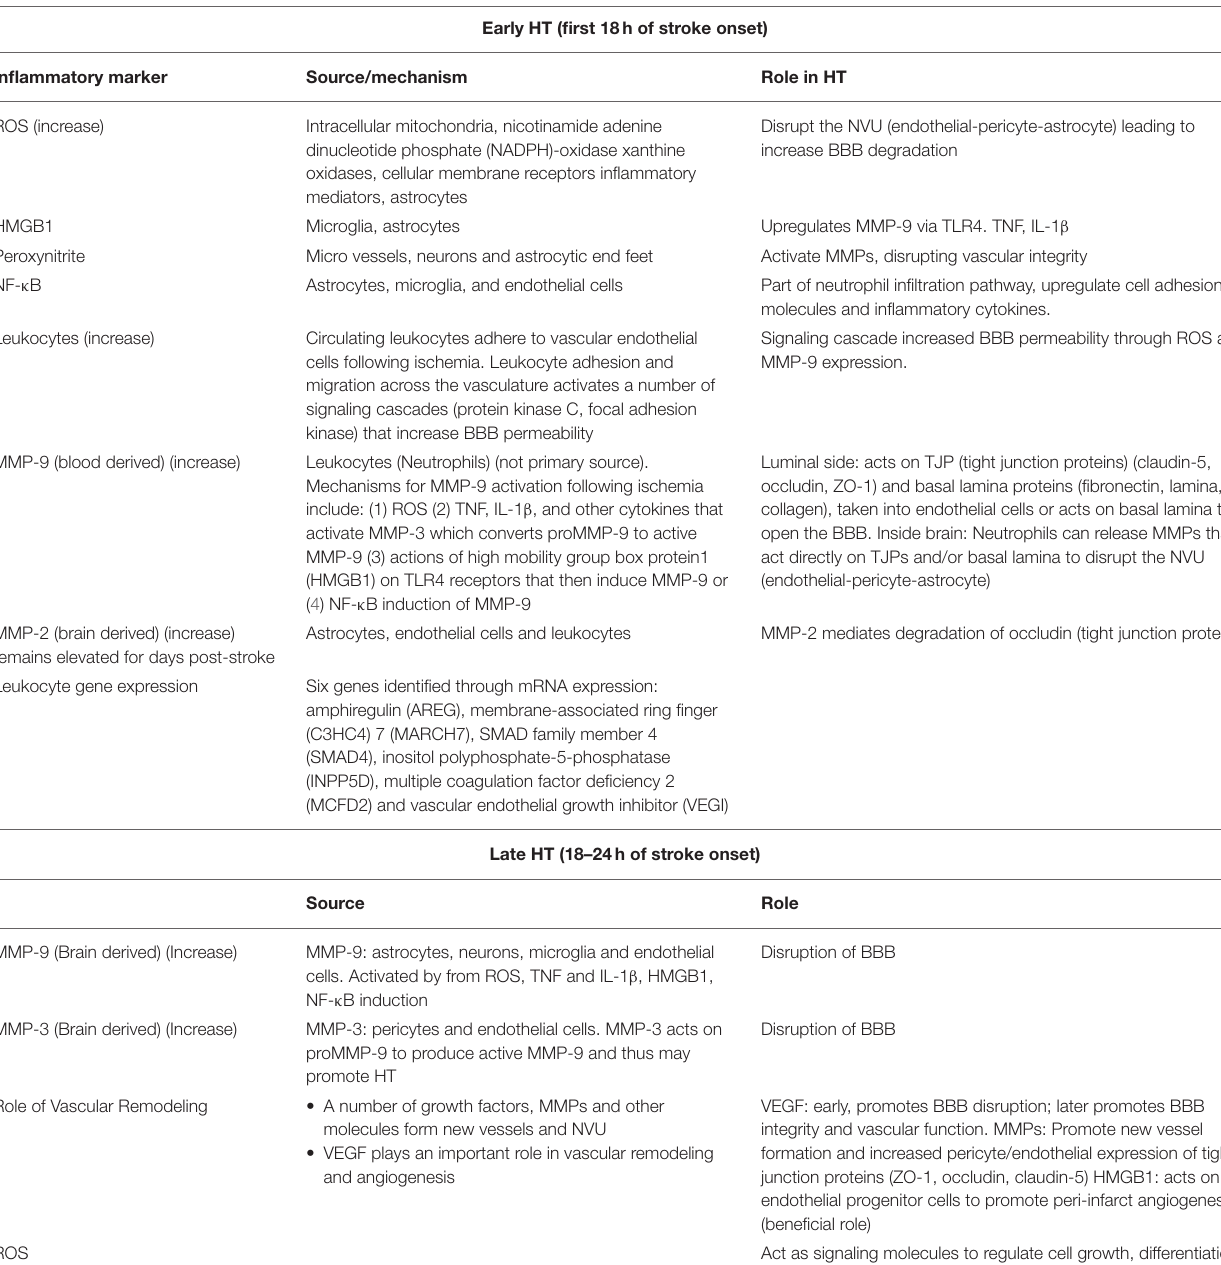
TABLE 2 | Inflammatory markers associated with